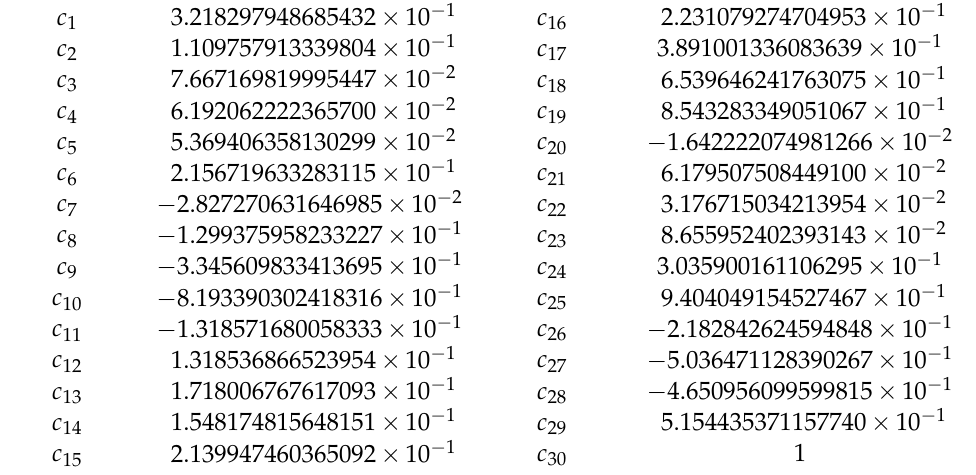
Table 4. Coefficients of y 05 , y 15 , y 25 from (91)–(93) for computing the Taylor approximation